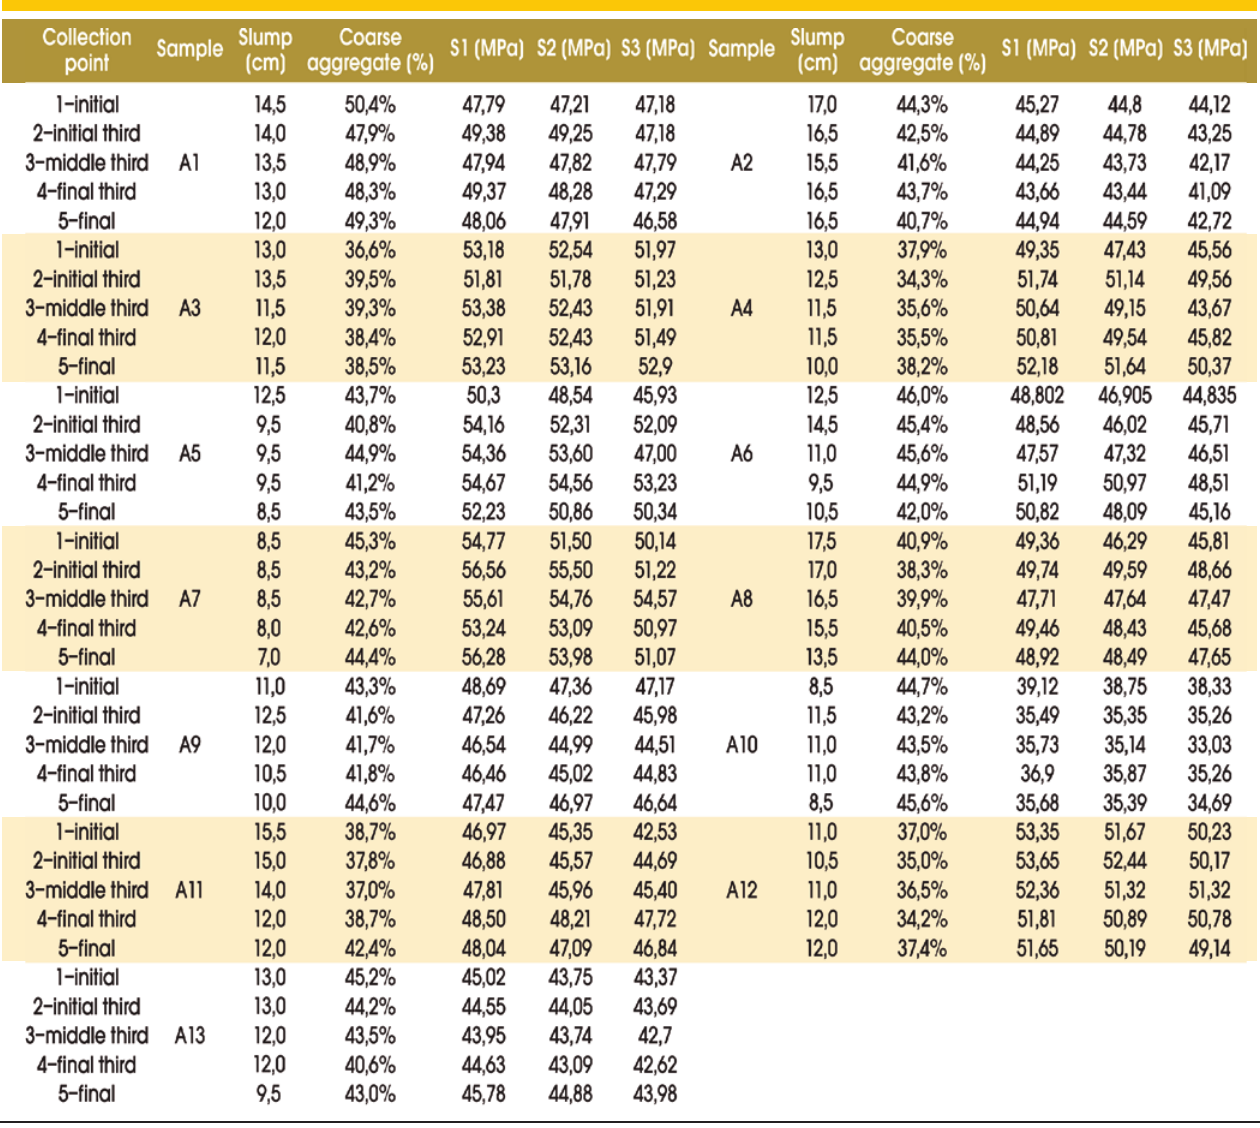
Table 1 – Data of slump test, compressive strength and coarse aggregate